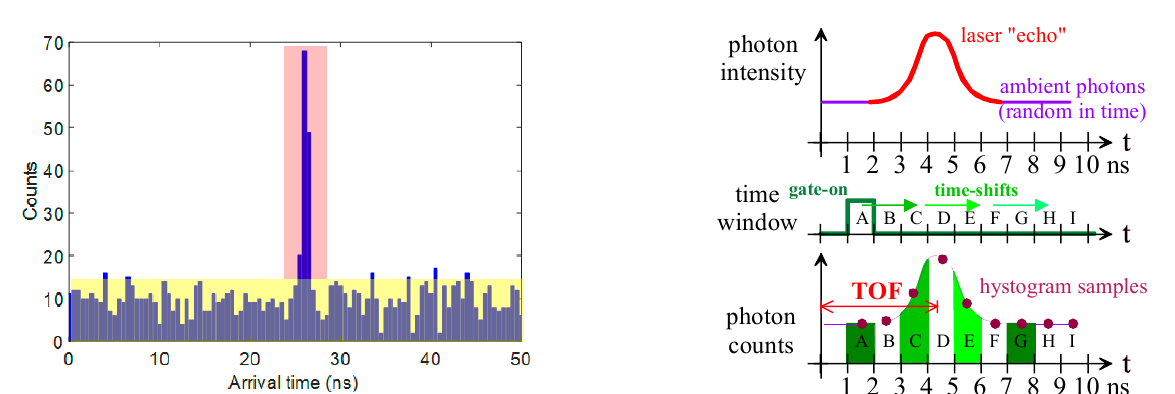
Figure 1. ( Left ) Typical photon-timing mode measurement: randomly scattered events (yellow background) are due to ambient photons (and dark count rate), while time-correlated photons close to each other (red area) belong to the laser pulse return “echo”. ( Right ) Typical time-gated photon-counting procedure: a gate-on window, in which the SPAD is activated, is progressively shifted across the entire full-scale range, thus reconstructing the optical “echo” of the laser pulse.